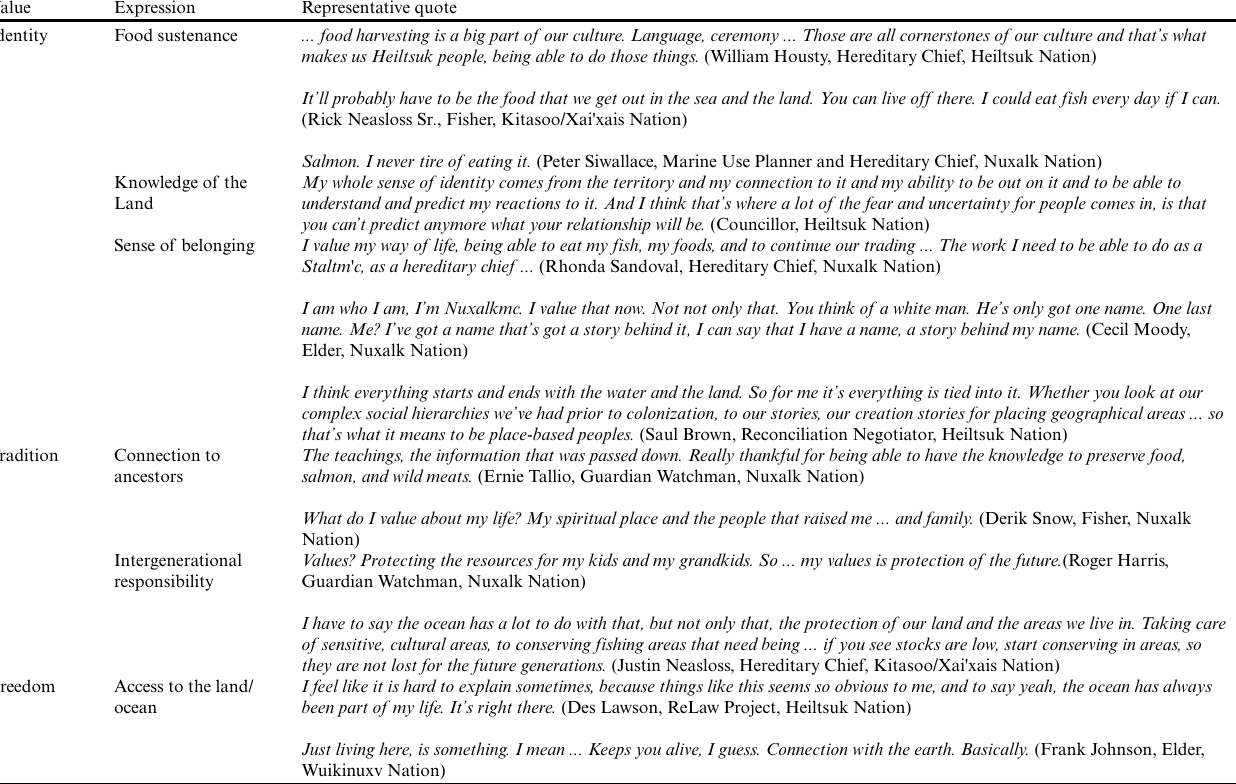
Table 2 . Values related to participants’ ways of life. Quotes without direct attributions are anonymous.